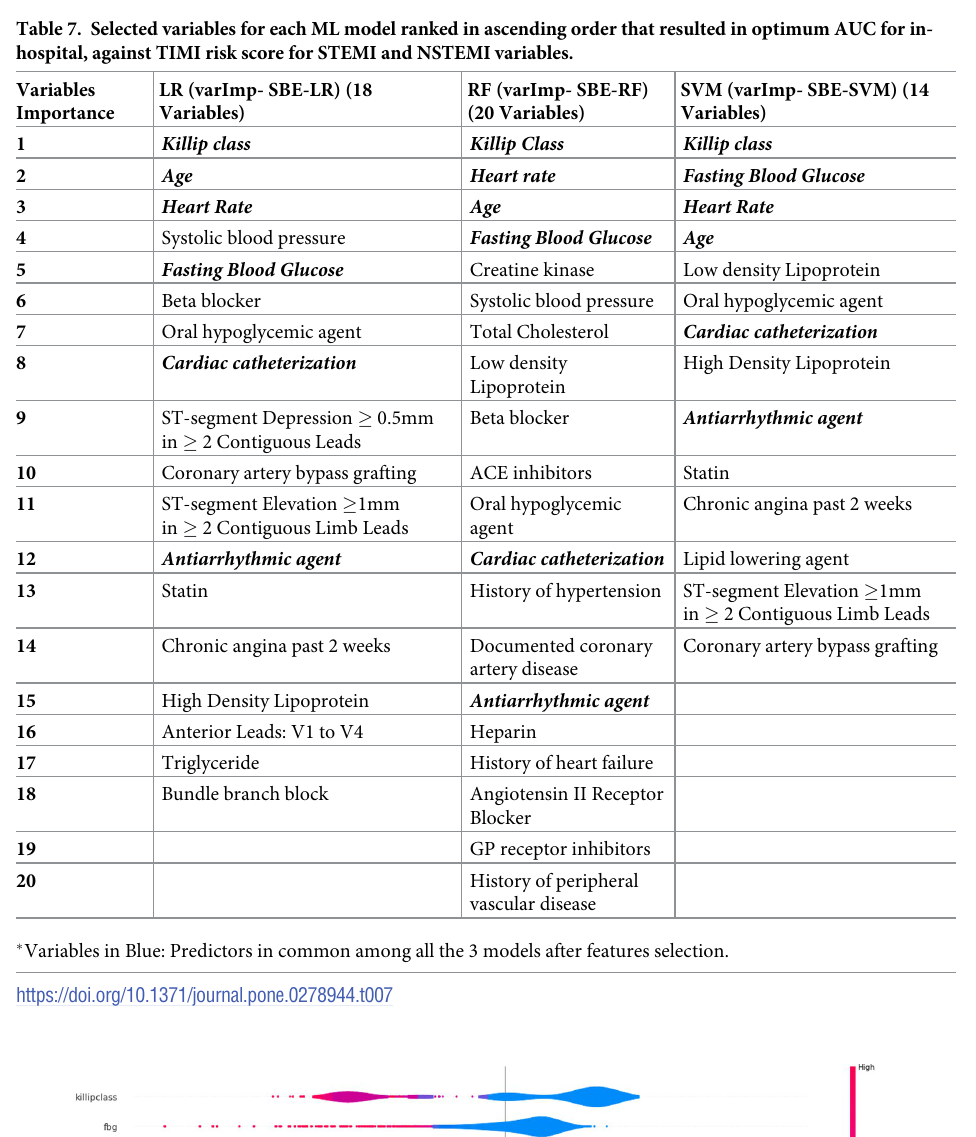
Table 7. Selected variables for each ML model ranked in ascending order that resulted in optimum AUC for in- hospital, against TIMI risk score for STEMI and NSTEMI variables.